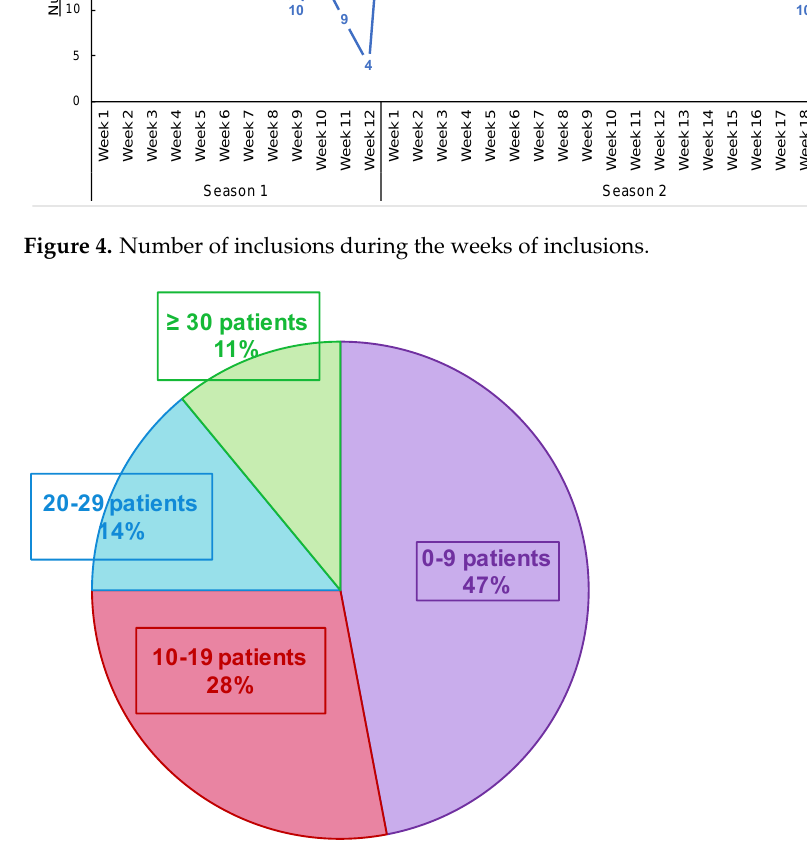
Figure 5. Number of included patients by the GPI during the two epidemic seasons.